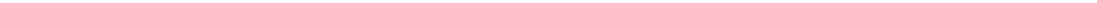
Fig. 4 IPA affects synaptic localization of GluA1 and AMPA currents in hippocampal neurons. a Immunoblots of control ( – ) and BS 3 cross-linked (+) surface exposed receptors upon treatment with vehicle (CTR) or IPA showing cytoplasmic GluA1 monomers (C) and surface subunit tetramers including GluA1 (S). b Densitometry of both cell surface (left) and intracellular (right) GluA1 fractions normalized to tubulin; the experiment was repeated six times (statistics by Mann – Whitney test). c Immuno fl uorescence analysis of surface GluA1 in hippocampal neurons. A magni fi cation is shown in the box (right); scale bar = 5 μ m. d Immunoblots of GluA1 interaction with both PSD95 (top) and actin (middle). On bottom, cell lysates probed with α -PSD95, α -actin, and α -GluA1. The experiment was repeated four times. e Confocal images of immuno fl uorescence double staining of neurites upon IPA treatment. PSD95 (fuchsia) and GluA1 (green) immunoreactivity are merged. Neurites are visualized by phalloidin staining and differential interference contrast image (DIC). Arrows show dendritic spines exhibiting co-localization of GluA1 and PSD95; scale bar = 10 μ m. f Representative traces (top) and bar graphs showing mean AMPAR (bottom, left) and NMDAR currents (bottom, right) in autaptic neurons exposed to vehicle (CTR), IPA, or insulin and oleic acid (IOA); recordings for AMPAR currents: n = 21 per each group (statistics by one-way ANOVA and Student – Newman – Keuls post hoc). g Representative traces (top) and bar graphs showing mean mEPSC frequency (bottom, left) and amplitude (bottom, right) in autaptic neurons; mEPSC recordings: n = 21 controls, n = 20 IPA, n = 20 IOA (statistics by one-way ANOVA and Student – Newman – Keuls post hoc). h Immunoblots and densitometry of chemical LTP- dependent pGluA1 Ser 845 in hippocampal neurons. Experiment was repeated four times (statistics by two-way ANOVA and Bonferroni post hoc). Data are shown as mean ± SEM * p < 0.05; ** p < 0.01; *** p < 0.001; n.s. not signi fi cant. See also Supplementary Fig.